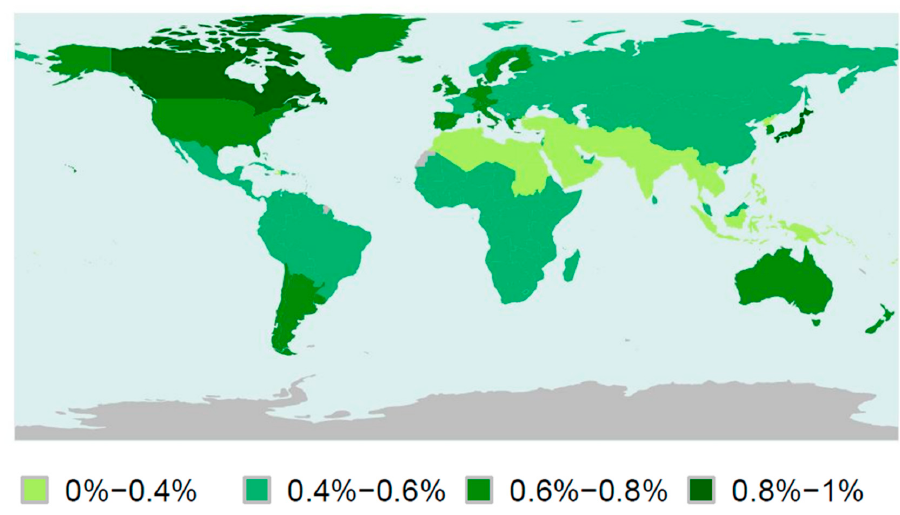
Figure 1. Map of the prevalence of Autism Spectrum Disorders (ASD) around the world in 2017. Light green: prevalence between 0–0.4%; blue: prevalence between 0.4–0.6%; green: prevalence between 0.6–0.8%; dark green: prevalence between 0.8–1%. Countries from which no data are available are plotted in grey. The figure was elaborated using R software (R Core Team, Vienna, Austria) to represent open access data which have been previously standardized to age and sex [2,4,6].